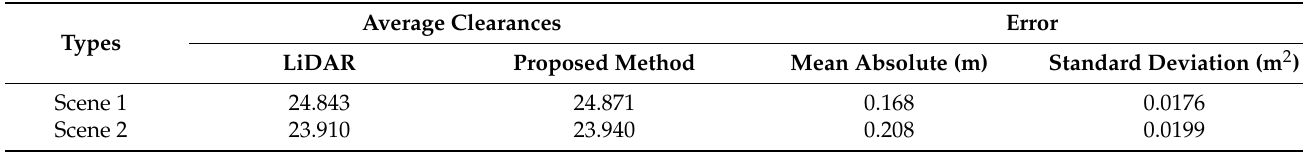
Table 7. The mean and standard deviation of the errors within the average of calculated ground clearance distances.